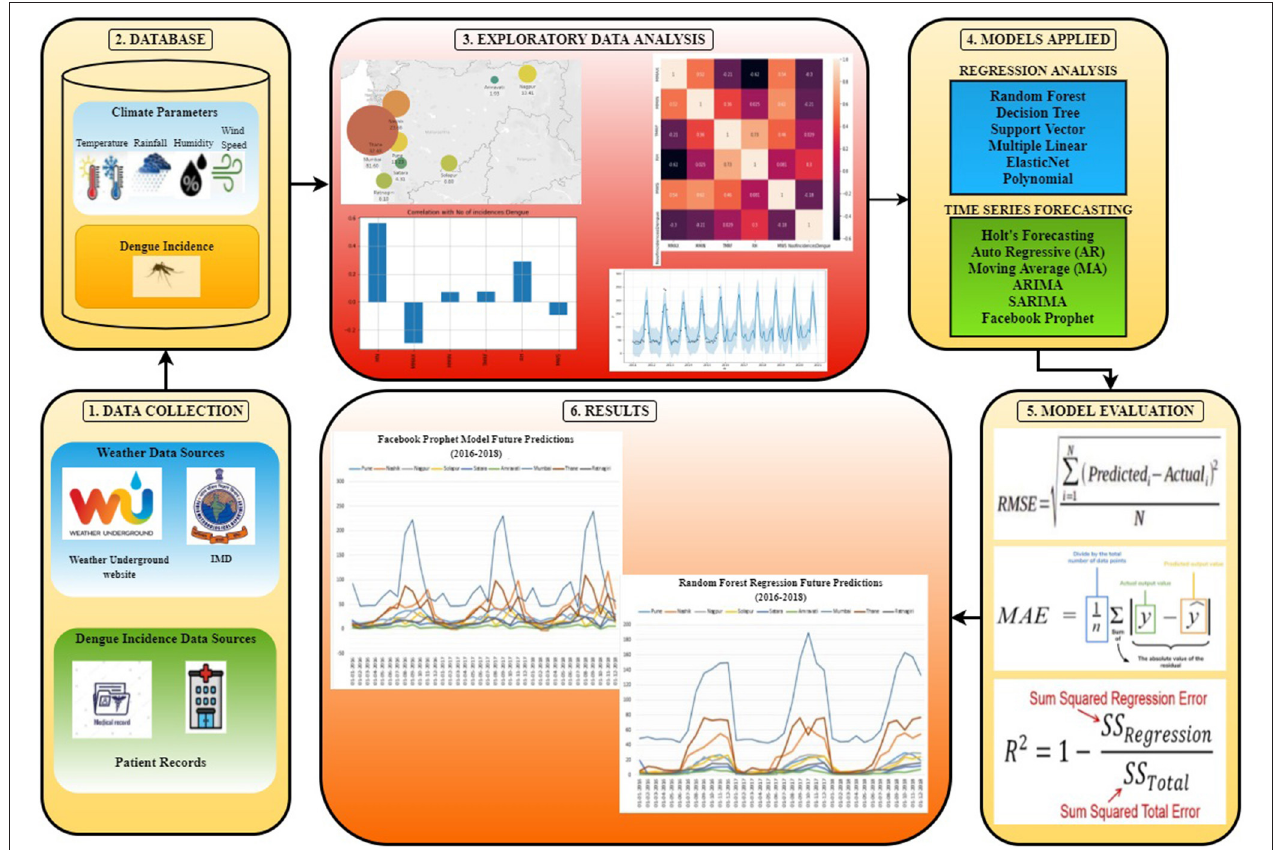
FIGURE 1 | Effects of climate change on disease